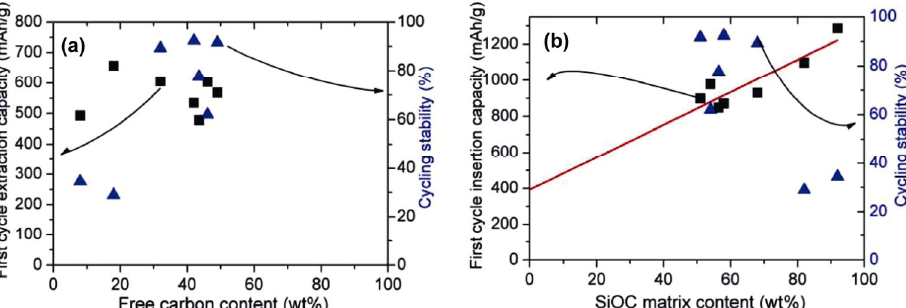
Fig. 22 Dependence of the lithiation/delithiation capacity of SiOC-derived materials on the amount of free carbon (a) and on the amount of SiOC matrix (b). Reproduced with permission from Ref. [435], © the authors 2015.